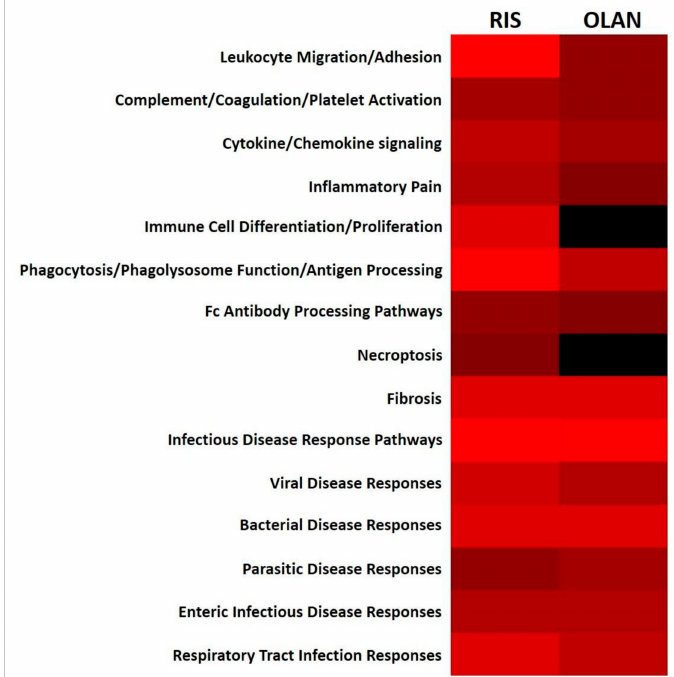
Figure 4. Dysregulation of immune function pathways during risperidone and olanzapine treatment. DE proteins measured in this study are integral parts of several immune function pathways in the KEGG database. The number of proteins altered in RIS- or OLAN-treated mice (relative to VEH-treated controls) in each pathway group were tabulated. The intensity of red ( λ = 100–255 nm) reflects the number of proteins per pathway significantly di ff erent from VEH-treated mice during RIS treatment (left panel) and OLAN treatment (right panel). Absence of any altered proteins in a particular pathway is depicted in black ( λ = 0